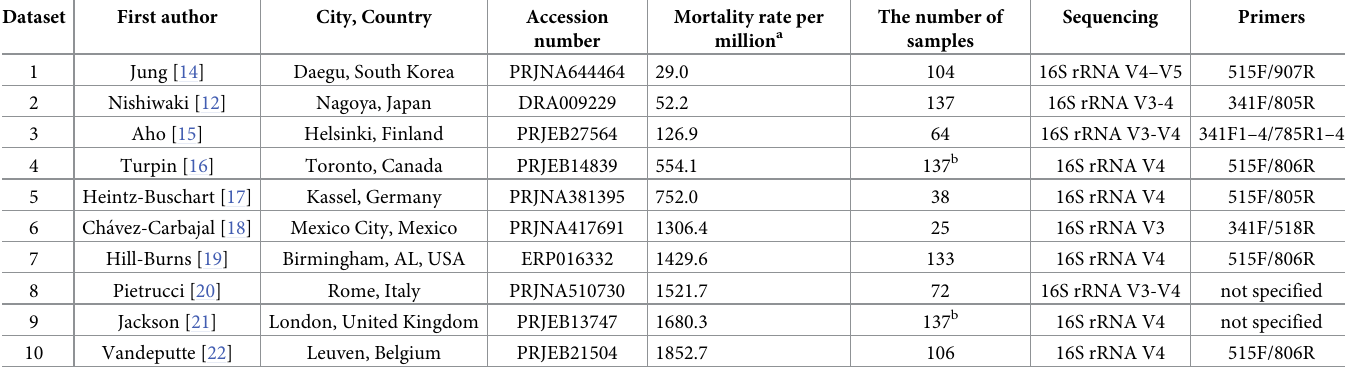
Table 1. Ten 16S rRNA-seq datasets from ten countries and the mortality rates of COVID-19. Dataset